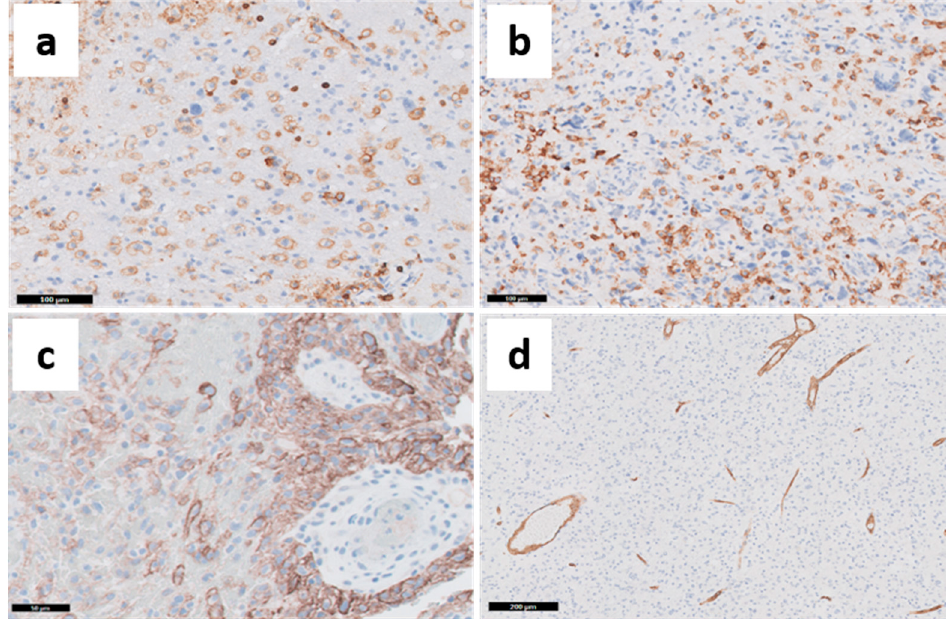
Figure 6 Figure 6. Characterization of TME with IHC markers. ( a ) CD45 expression: hematopoietic cells (both lymphocytes and macrophages). ( b ) CD163 expression: M2 macrophages. ( c ) PDL-1 expression: presence of positive tumor cells in the perivascular space. ( d ) CD34 expression: endothelial cells. Representative images captured from OSU Tissue